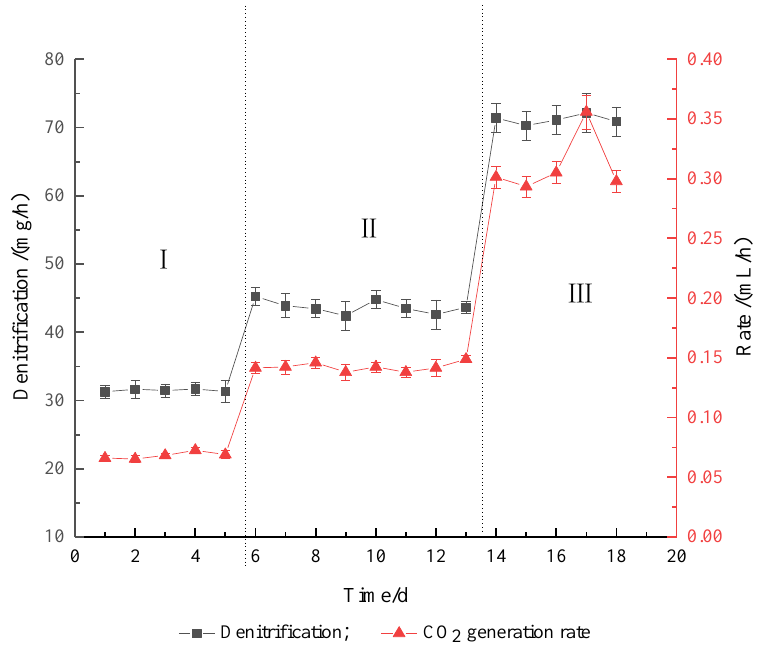
Figure 7. Relationship between CO 2 consumption and amount of denitrification in anammox; Stages I, II, and III indicate that HRT is 33.4, 24, and 14.5 h, respectively.